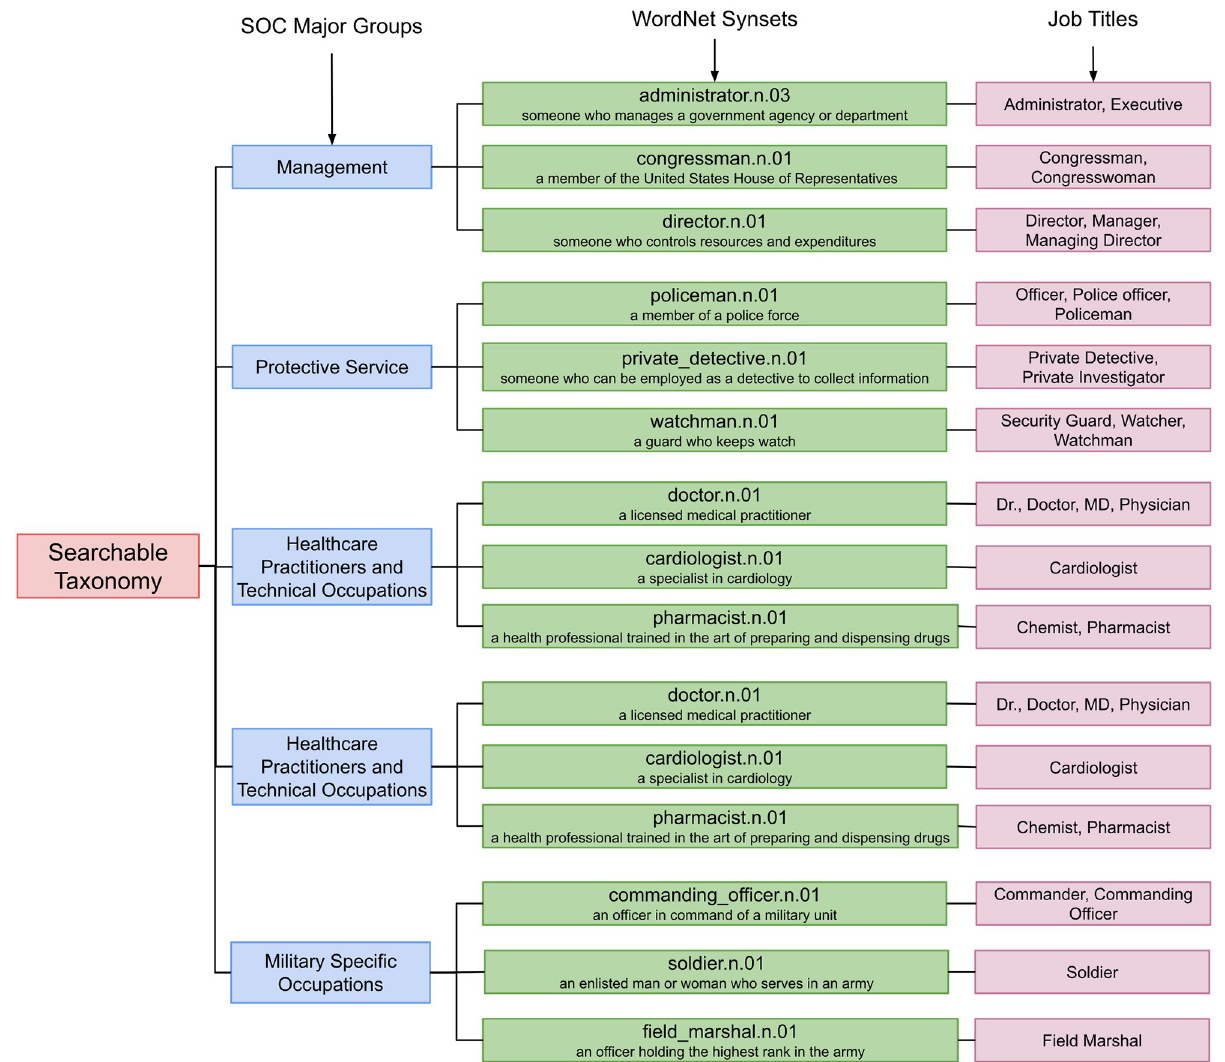
Fig 5. Searchable profession taxonomy. The SOC-mapped expanded profession taxonomy contains 3 tiers: SOC major groups, WordNet synsets, and job titles. The synsets and unigram job titles make the taxonomy searchable. This figure shows a few nodes of the SOC-mapped taxonomy, which contains 500 job titles and 562